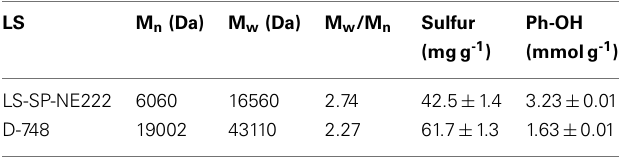
Table 3 | Comparisons of MWs and sulfur and Ph-OH contents of the LS from SPORL pretreated NE222 at the pilot scale with sulfuric acid and sodium bisulfite loading on wood 1.1 and 3.0 wt%, respectively, for 40min at 160°C with those of a commercial LS from sulfite pulping of softwoods